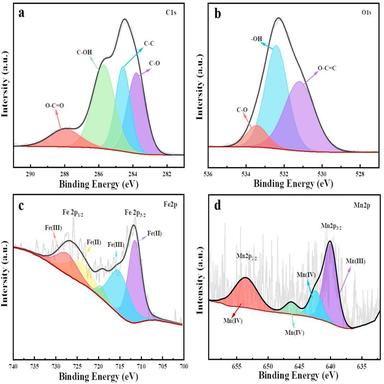
XPS spectra of Fe–Mn NPs: C 1s (a), O 1s (b), Fe 2p (c) and Mn 2p (d).